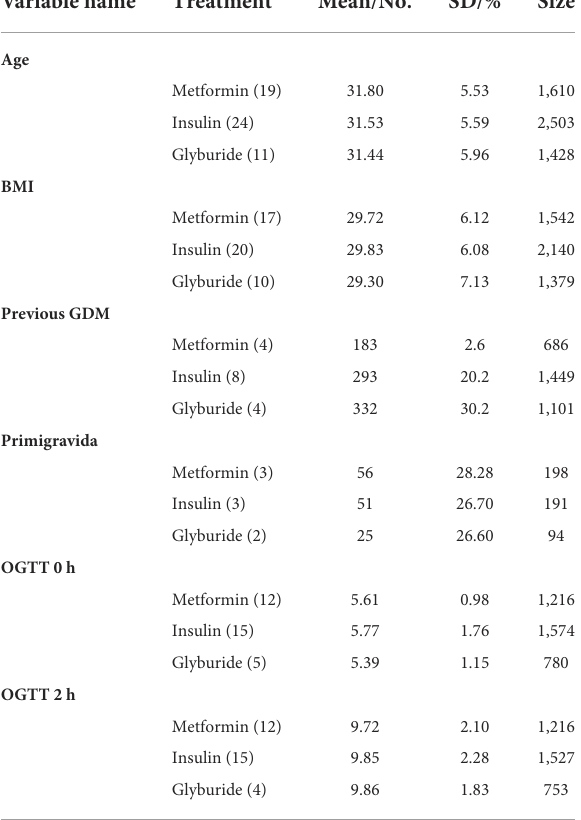
TABLE 1 Baseline clinical characters of GDM women in different arms of the Bayesian network-analysis. Variable